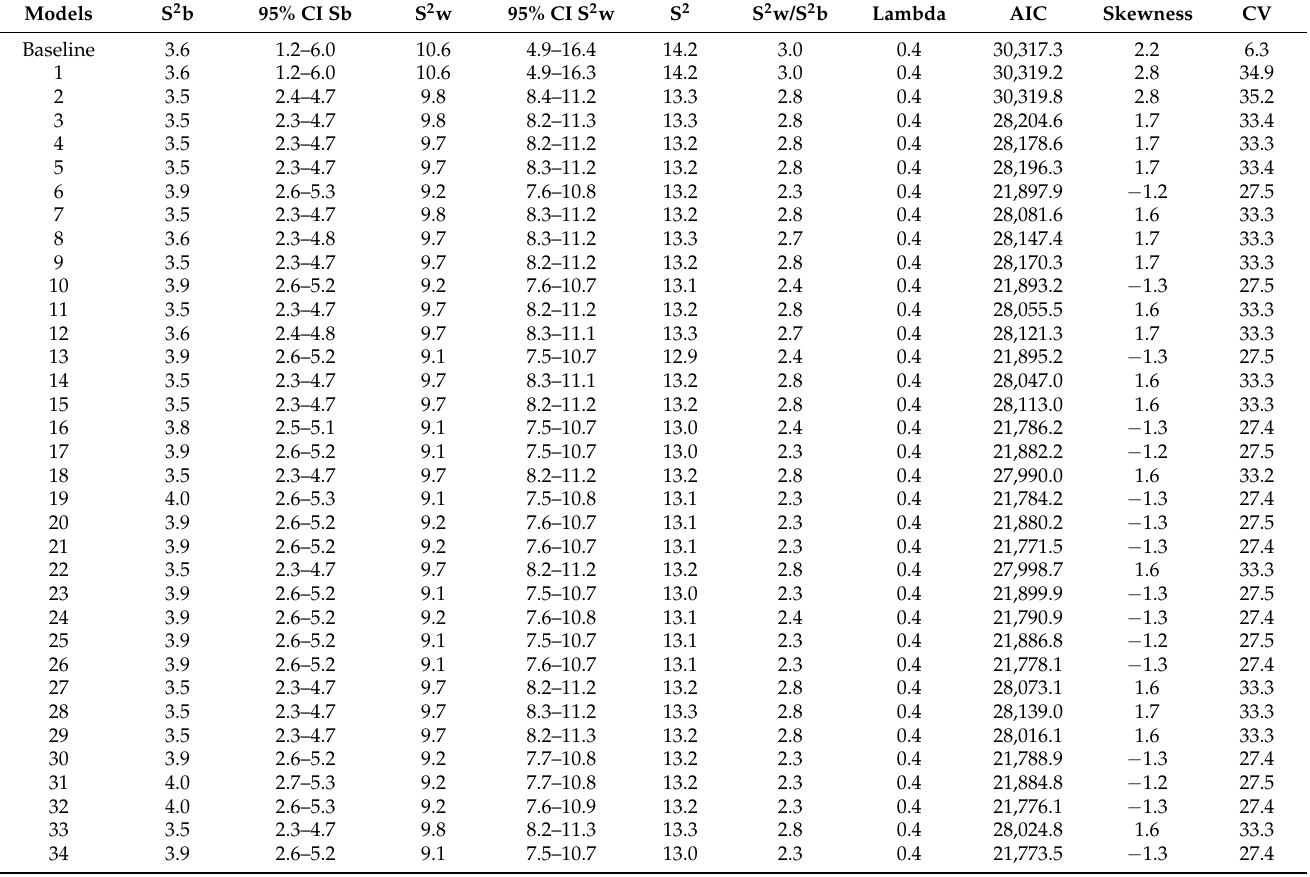
Table 4. Parameters of usual iodine intake estimates and Akaike Information Criterion according to Models, Multicenter Study of Iodine Deficiency, Brazil,